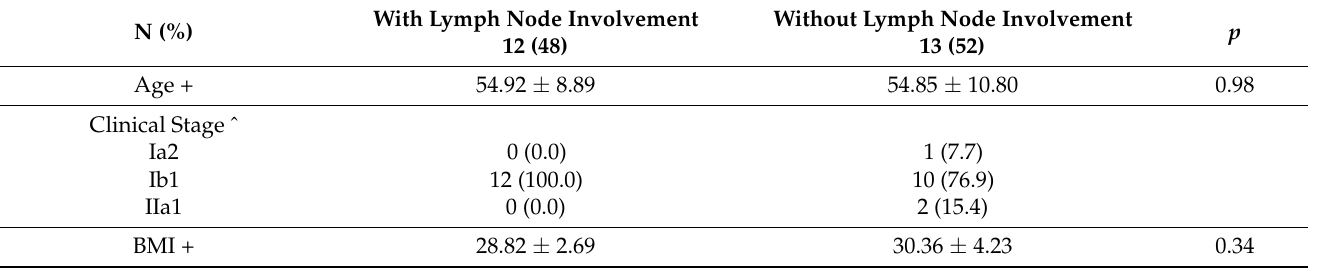
Table 1. Clinical and histopathological characteristics of the patients with cervical carcinoma analyzed in this